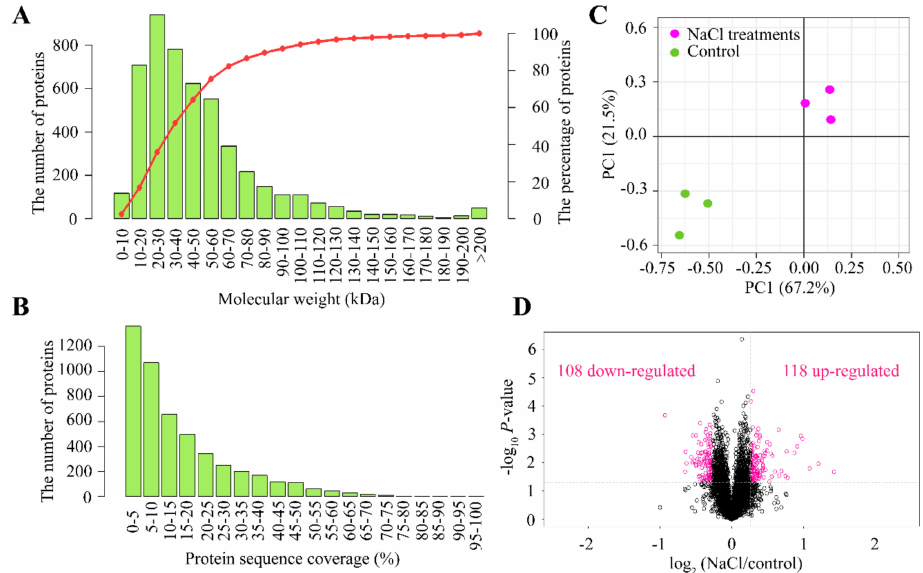
Figure 3. Protein coverage and di ff erentially abundant proteins (DAPs) between NaCl treatments against control. ( A ) Numbers of proteins against di ff erent molecular weights. Y-axis on the right side represents the percentage of proteins and is indicated by the red line, while the Y-axis on the left side represents the number of proteins and is shown with green bars. ( B ) Number of proteins against di ff erent protein sequence coverages. ( C ) Principal component analysis (PCA) on three di ff erent biological samples for either salt-untreated (control) or treated with 200 mM NaCl treatment for 14 d (NaCl). NaCl treatments and control are depicted in pink and green colors, respectively. ( D ) Volcano plots representing the proteins with significant di ff erences induced by 200 mM NaCl treatments for 14 d. Proteins with significant di ff erences and large fold changes are shown in pink scatters. 2.4. Gene Ontology (GO) and Kyoto Encyclopedia of Genes and Genomes (KEGG)